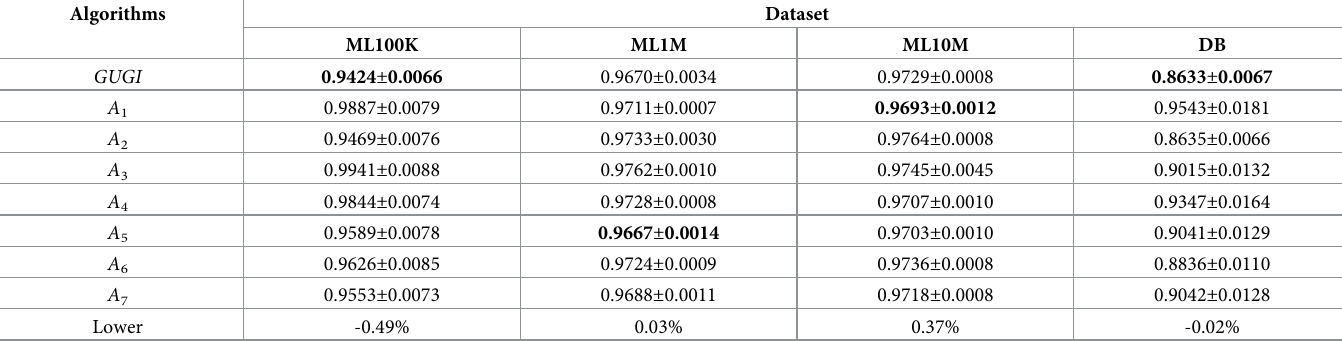
Table 8. RMSE comparison under k -means clustering.